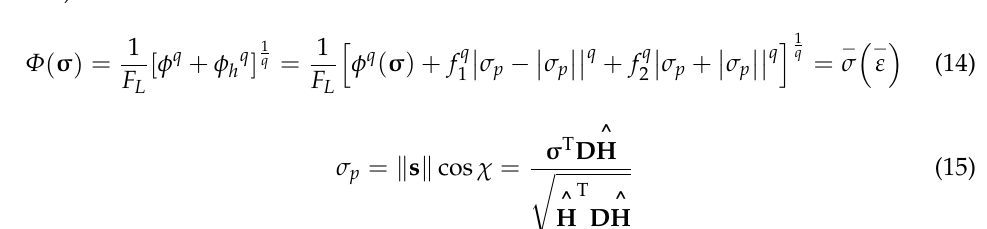
stress deviator s in the direction of the microstructure deviator h